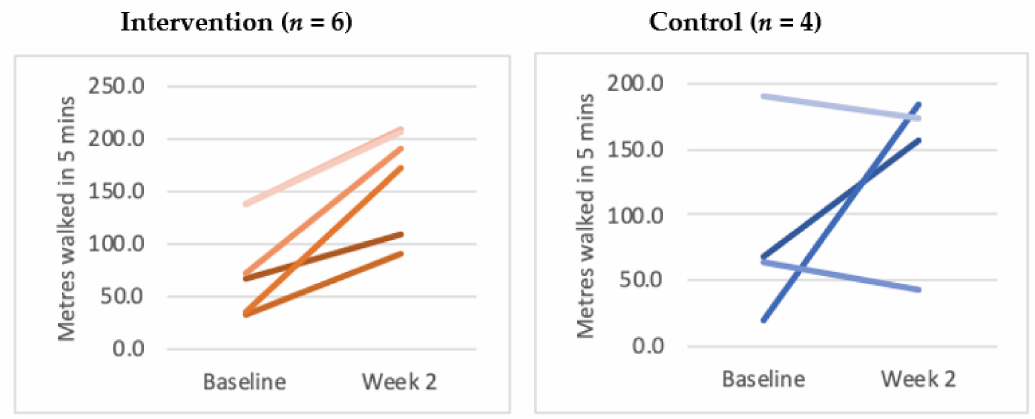
Figure 3. Distance walked in metres at baseline compared to week 2. (Please note: two of the lines in the intervention group